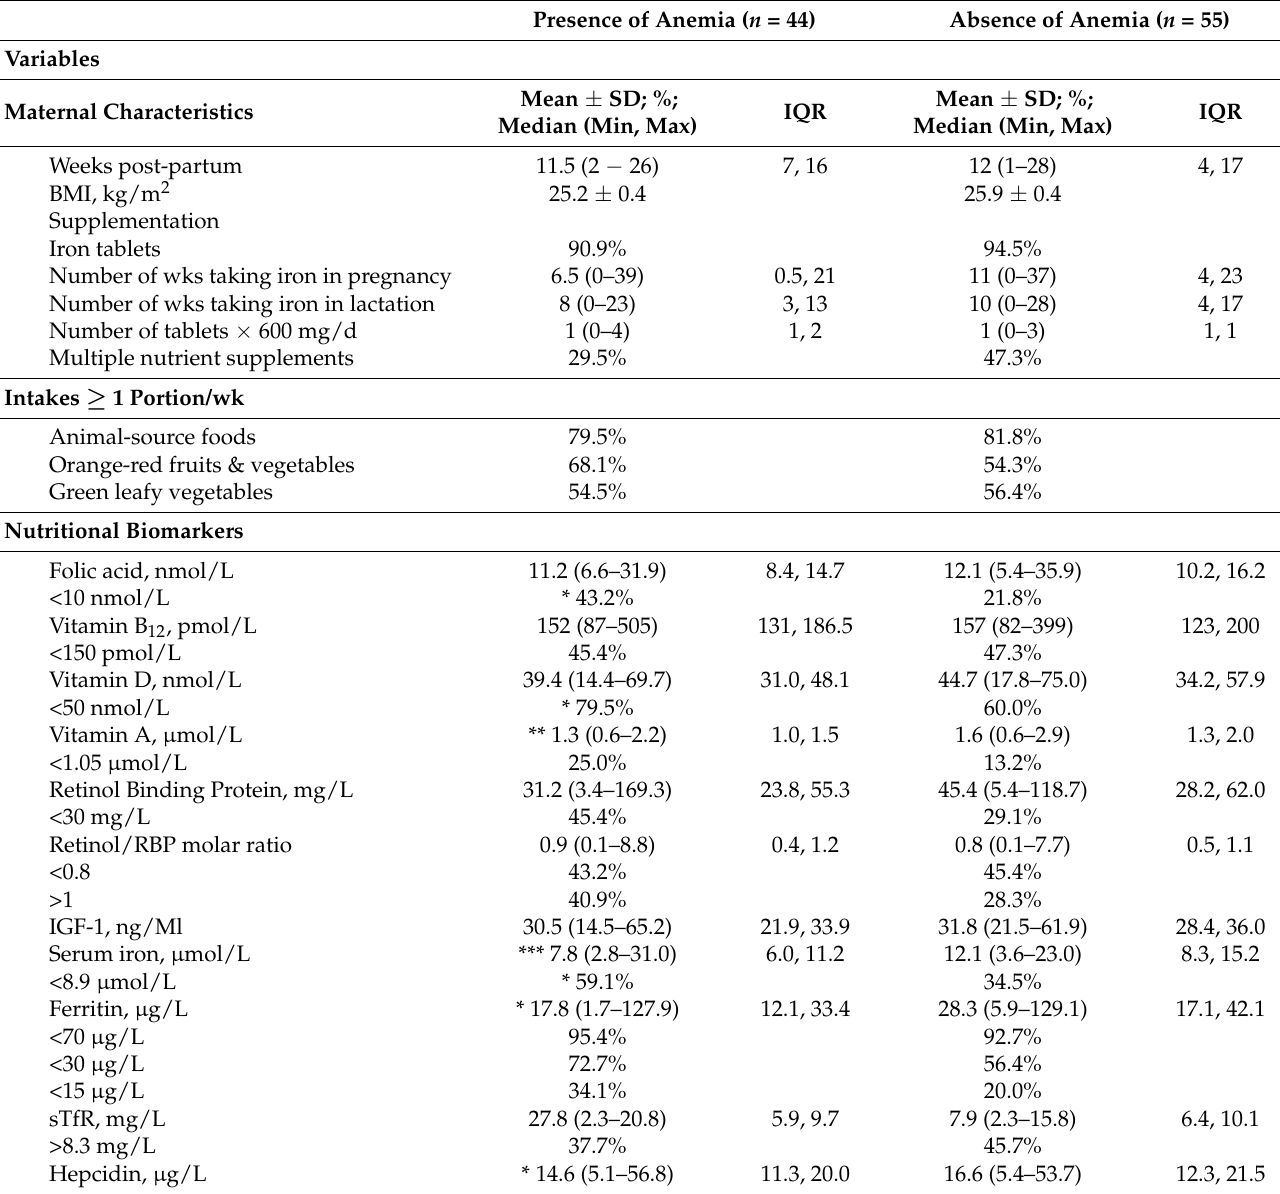
Table 3. Comparison of lactating indigenous women and their infants based on maternal anemia 1 . Presence of Anemia ( n = 44) Absence of Anemia ( n =